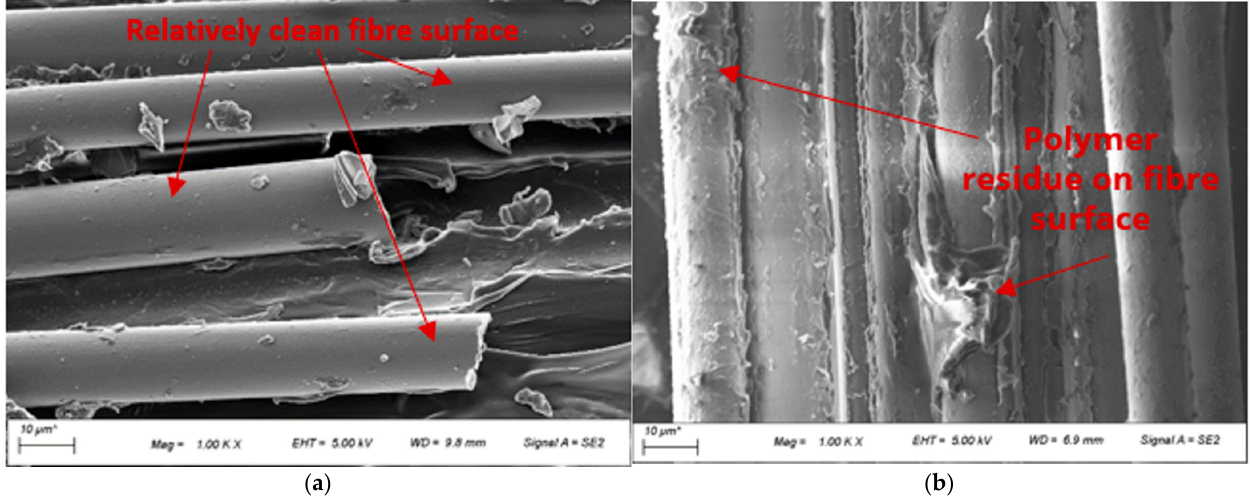
Figure 7. FESEM images of the BF-PP composites processed at the same conditions and ( a ) without compatibiliser and ( b ) with compatibiliser.